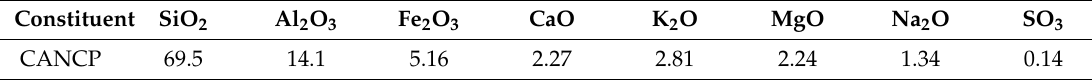
Table 7. Chemical composition of CANCP (%).